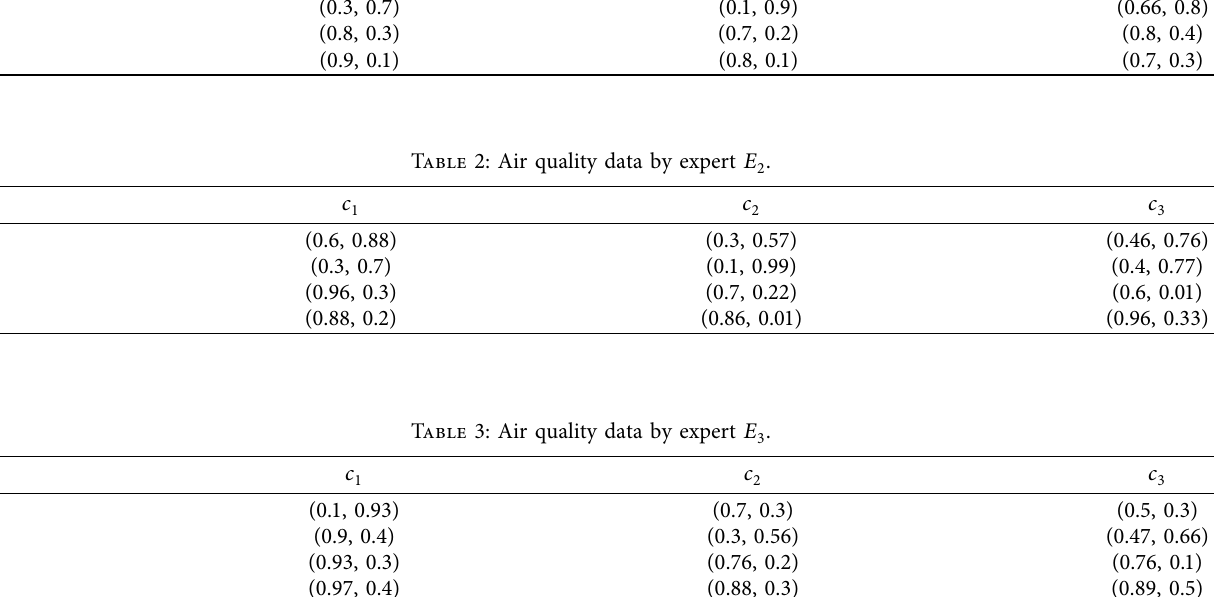
Table 1: Air quality data by expert E